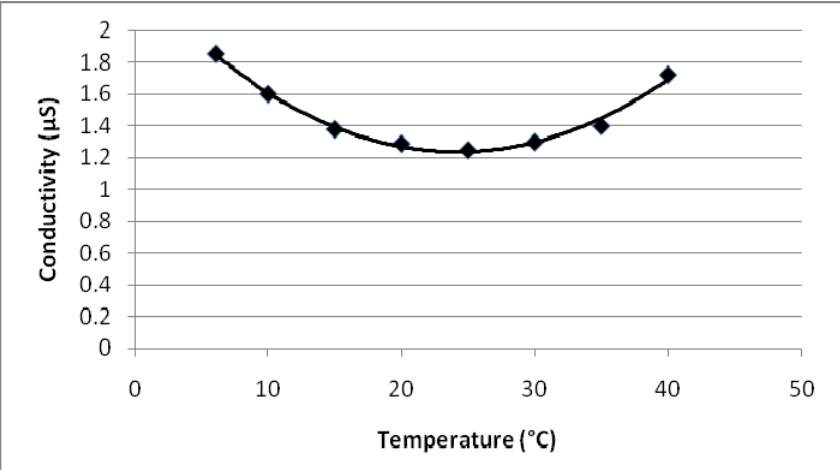
Figure 15. Conductivity vs. temperature change of copolymer (I) without dopant. Copolymer (I): (5% MMA, 95% EGDMA in monomer